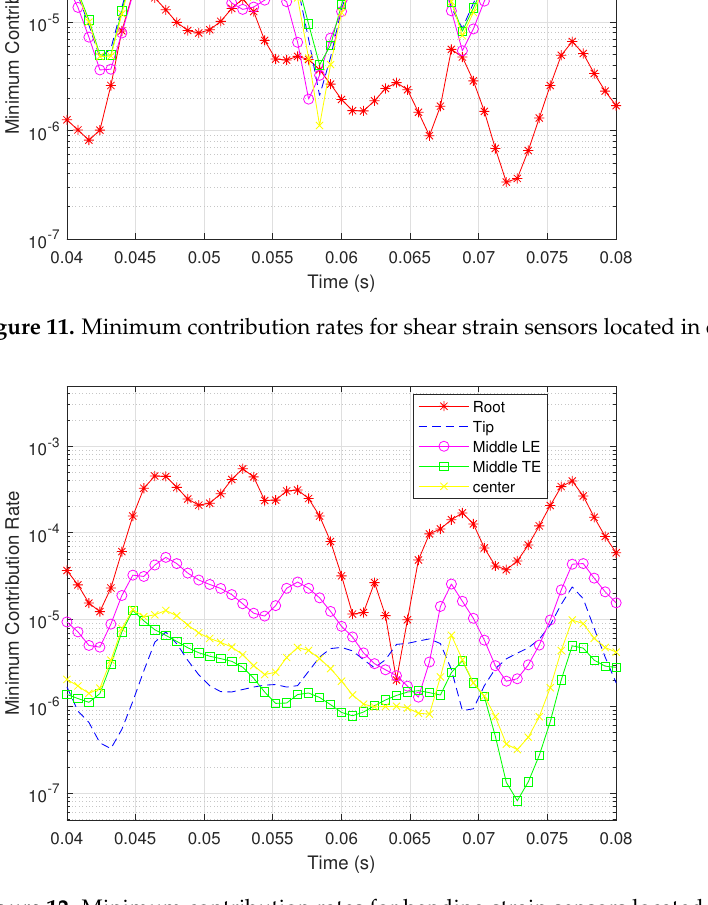
Figure 12. Minimum contribution rates for bending strain sensors located in different